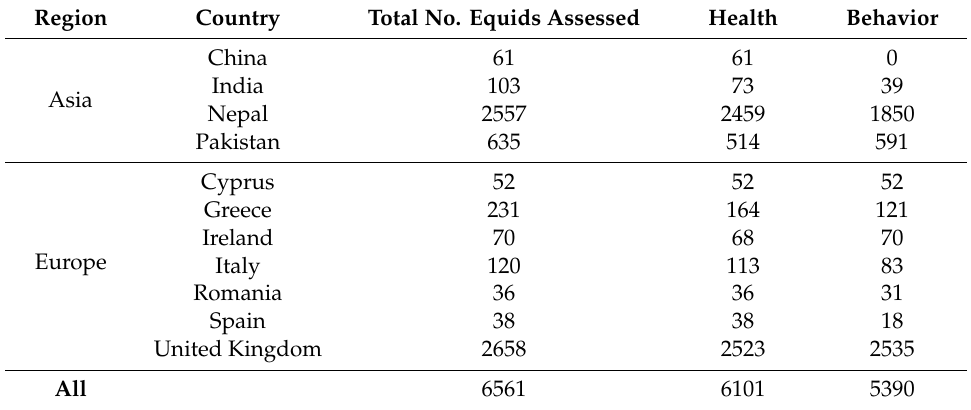
Table 3. The number of Equid Assessment Research and Scoping (EARS) assessments completed in each country, grouped by region. Numbers in the ‘behavior’ and ‘health’ columns indicate the assessments that provided su ffi cient data to complete the behavior and health decision trees,